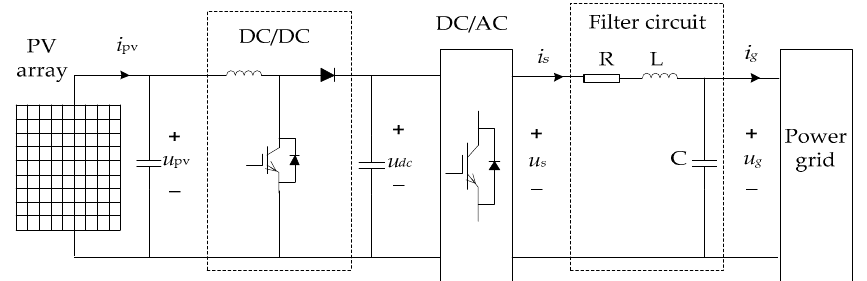
Figure 1. Topology of photovoltaic (PV) power.